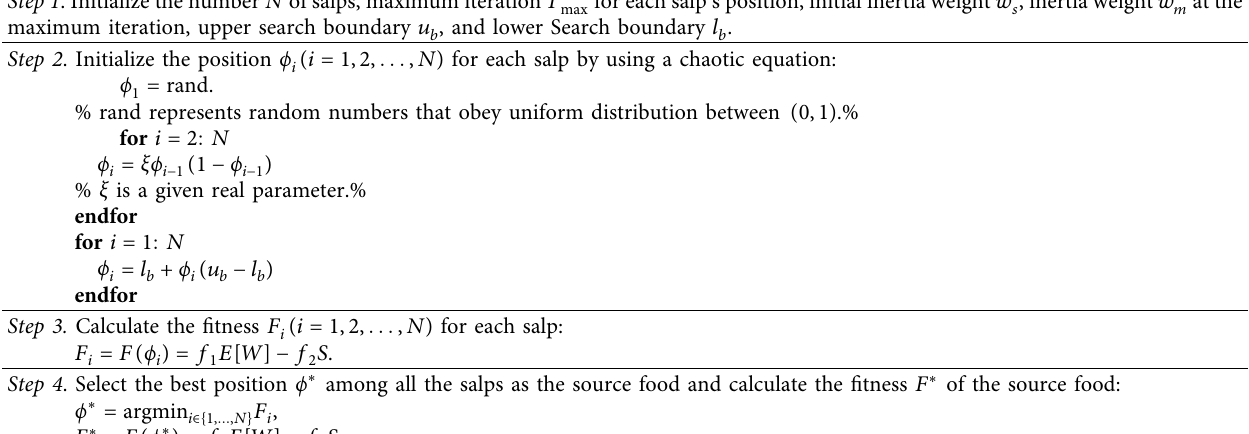
Table 3: Improved Salp Swarm Algorithm proposed to obtain the optimal sleep parameters. for each salp’s position, initial inertia weight w s , inertia weight w m at the Step 1 . Initialize the number N of salps, maximum iteration T max maximum iteration, upper search boundary u b , and lower Search boundary l b .